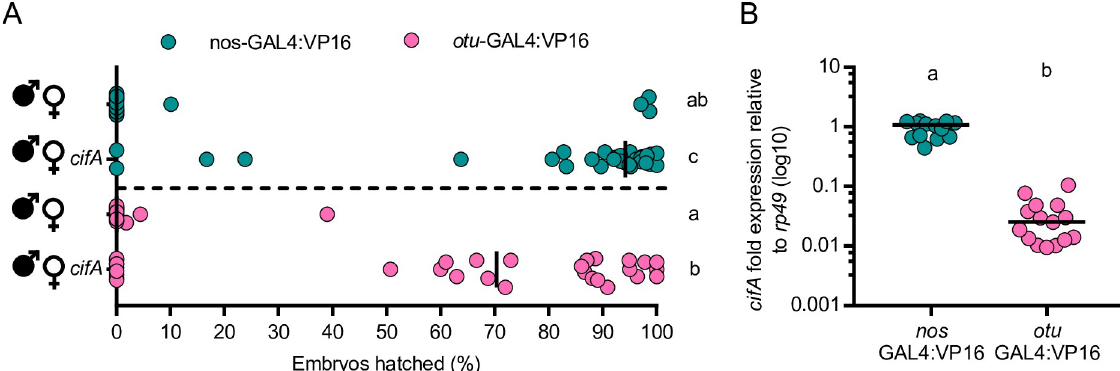
Fig 3. cifA wMel can induce strong rescue when expressed in uninfected females under the nos -GAL4:VP16 driver. (A) Two different driver lines, nos -GAL4:VP16 (green; top) and otu -GAL4:VP16 (pink; bottom), were tested for their ability to rescue w Mel induced CI. Filled sex symbols represent infection with w Mel Wolbachia , and gene names to the right of a symbol represent expression of those genes in the corresponding sex of that cross. Vertical bars represent medians. Letters to the right indicate significant differences with an α = 0.05 calculated by a Kruskal-Wallis analysis followed by Dunn’s multiple comparison test. (B) To test if nos-GAL4-tubulin and nos-GAL4:VP16 generate different levels of RNA expression, cifA wMel fold expression difference relative to the Drosophila housekeeping gene rp49 in male abdomens under the two drivers was measured using qPCR. Females tested for gene expression were the same used in the hatch rate experiment in A. Letters above indicate significant differences with an α = 0.05 calculated by a Mann-Whitney U